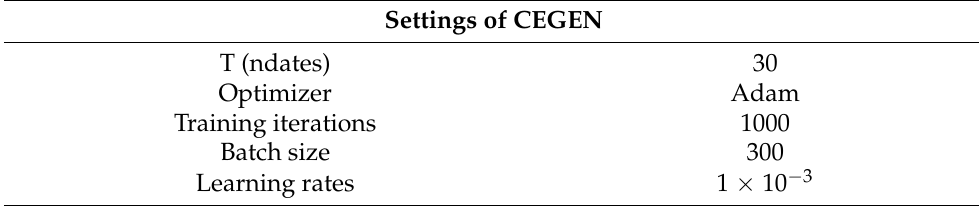
Table A1. Generator neural network hyper-parameters for